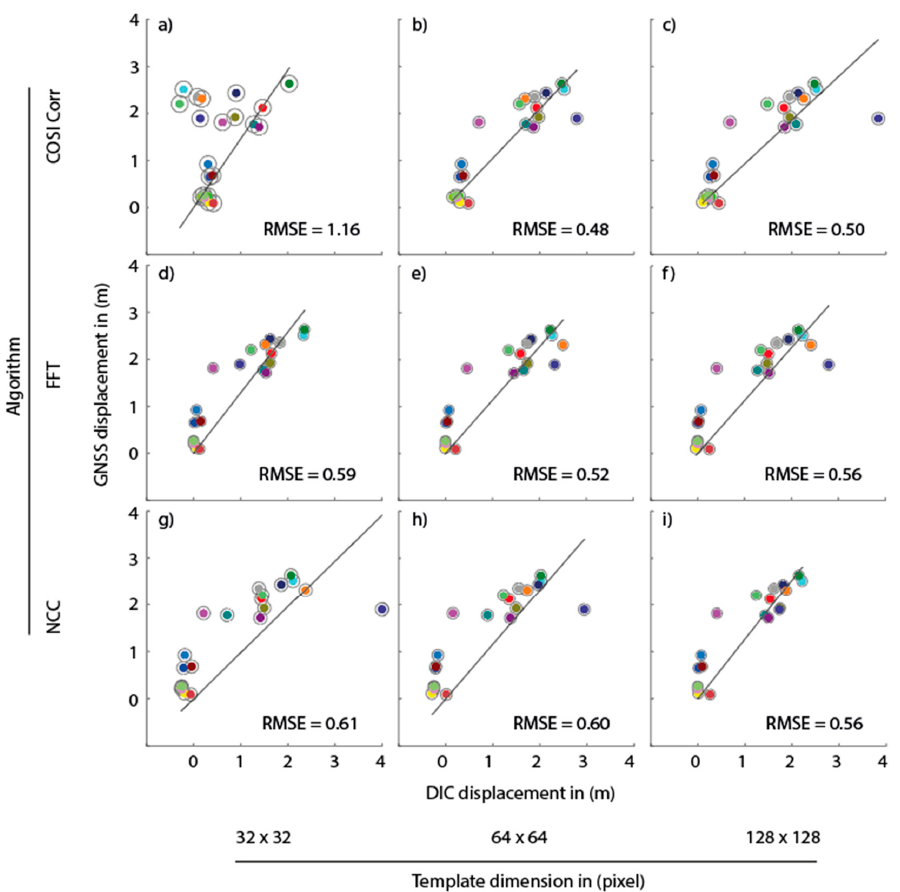
Figure 3. Direct comparison of measured displacements measured with GNSS (vertical) and DIC (horizontal) at each measurement point in the CdV AoI. Each dot represents one measurement location, color-coding corresponds to Figure 1 (GNSS measurement points). The columns display usage of scan window sizes from 32 × 32 to 128 × 128 pixels; the rows represent different algorithms. Each run’s RMSE value is displayed. Circles around the individual measurement points indicate the standard deviation of the respective run. All runs were Wallis filtered and vector filtered.